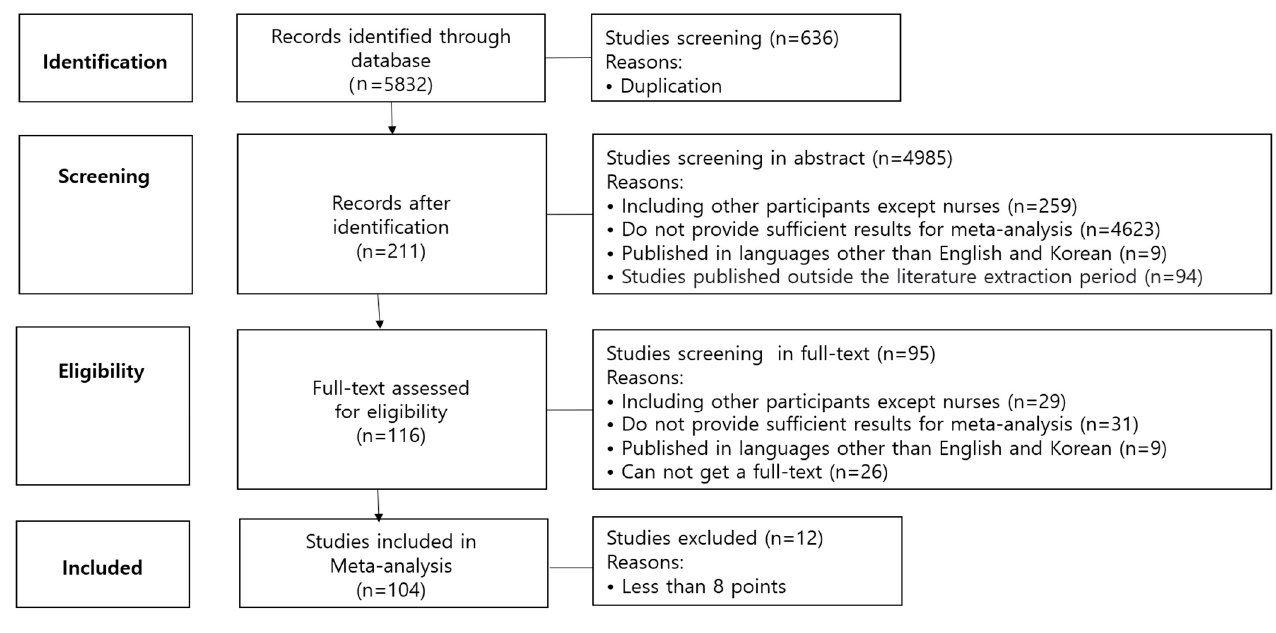
Figure 1. Flow diagram of study selection.